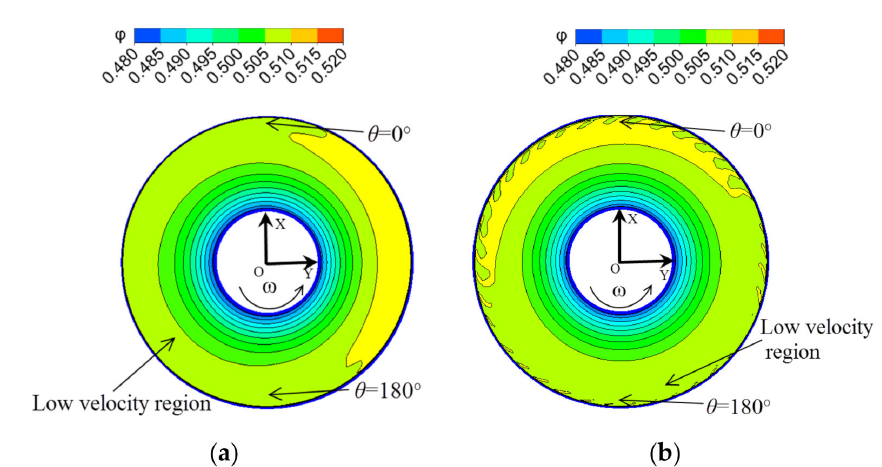
Figure 10. Distribution of inlet flow coe ffi cient near chock (NC) in the case of E = 160%. ( a ) Steady computational fluid dynamics (CFD) result; ( b ) unsteady CFD result.